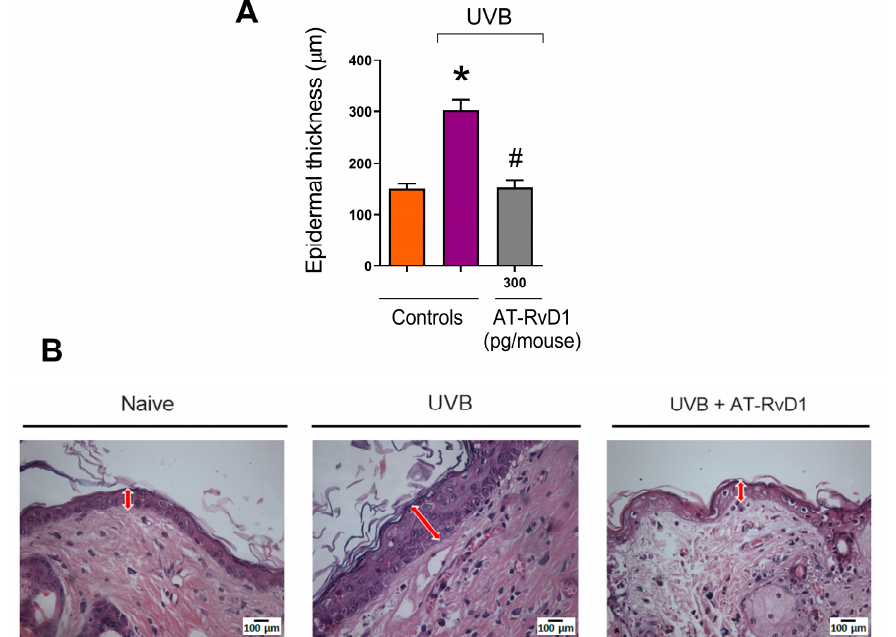
Figure 2. Effect of AT-RvD1 on epidermal hyperplasia of hairless mice exposed to 4.14 J/cm 2 UVB radiation. Epidermal thickness (µm) ( A ) and representative images of the epidermal thickness of the three tested groups—H&E stain ( B ). Skin samples were collected 12 h after the exposure. Arrows indicate representative epidermal thickness. Bars represent means ± SEM. Two separate experiments with five groups of 5 mice per group per experiment were performed. Statistical analysis was performed by one-way ANOVA, followed by Tukey´s post hoc test. * p < 0.05 compared to the nonradiated control group (orange bar); # p < 0.05 compared to the radiated control group (purple bar).